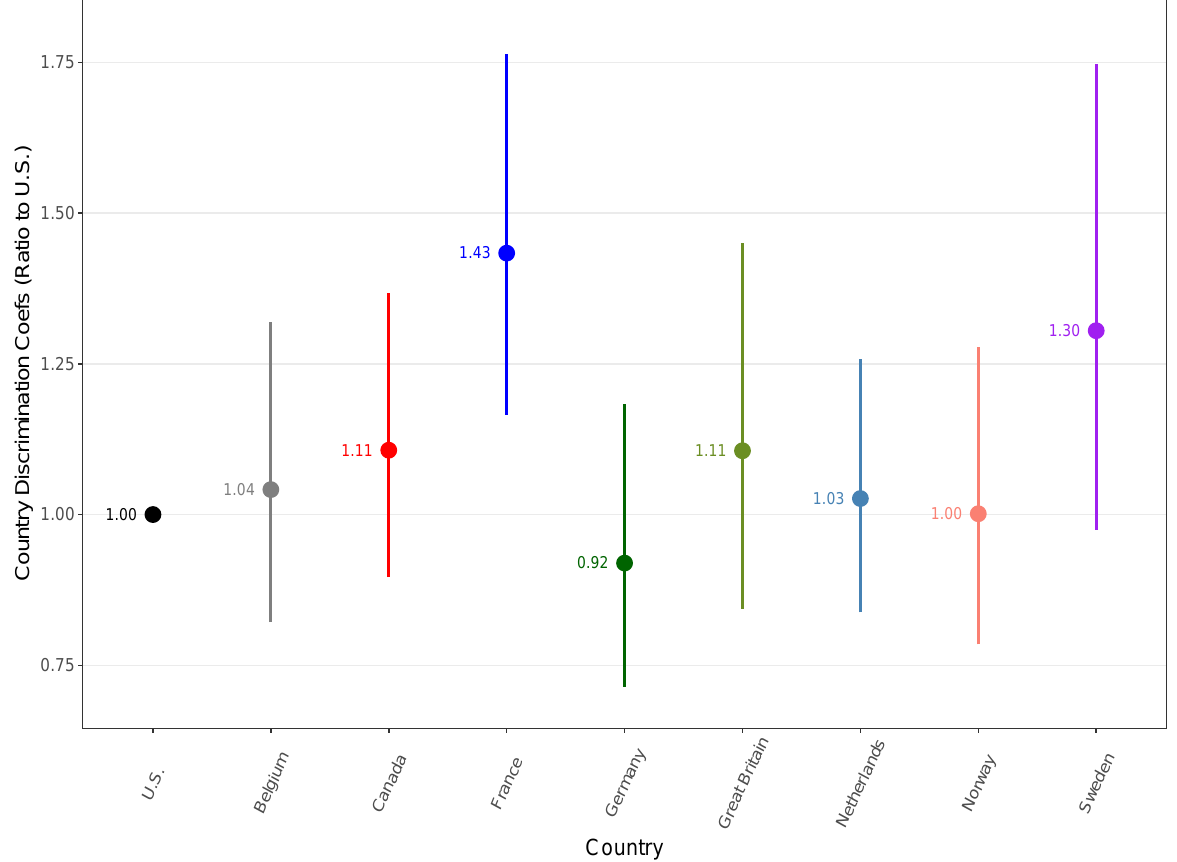
Figure 2: Country discrimination levels relative to the United States. Lines are 95 percent confidence intervals. Estimates are based on exponentiated coefficients from Table 3, model